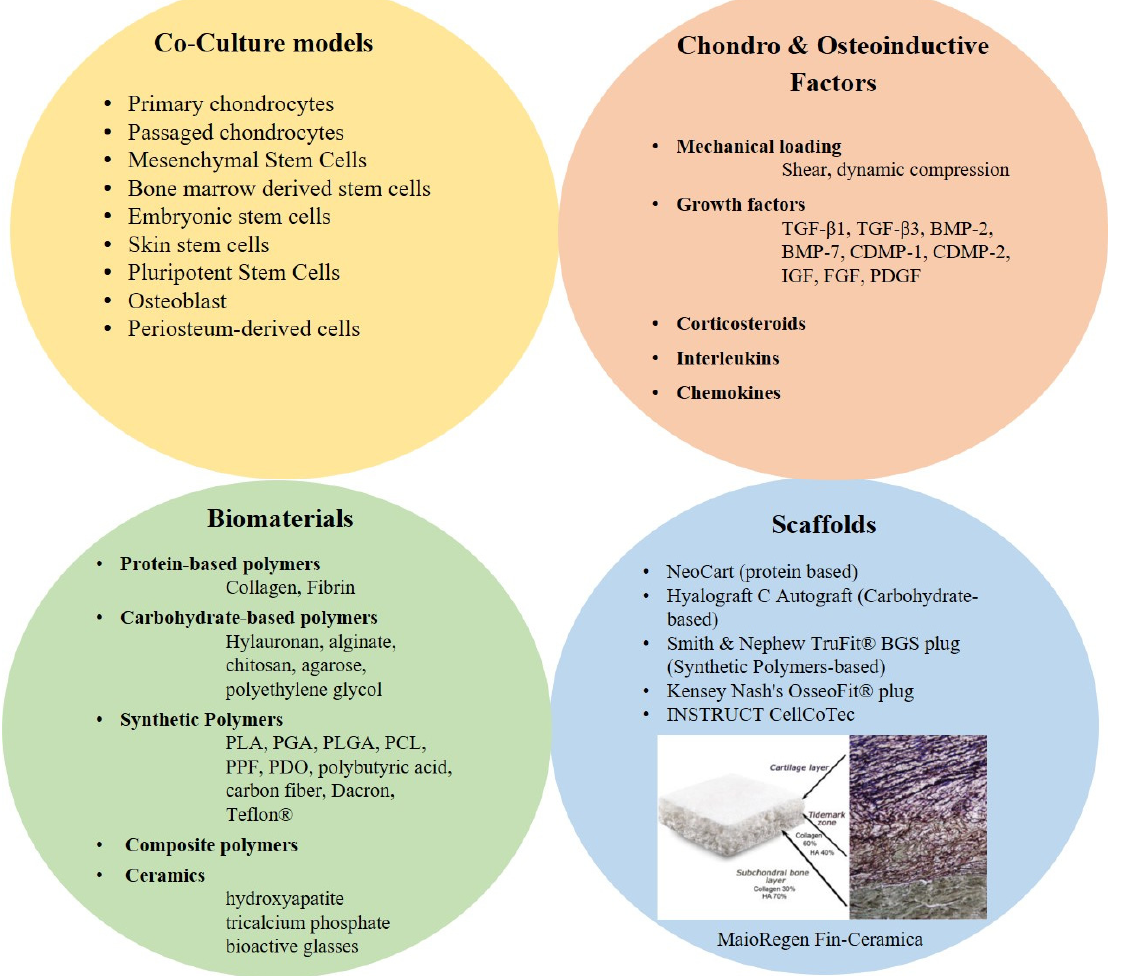
Figure 3. Tissue engineering solutions for osteochondral implants. Co-culture models, biomaterials, scaffolds and chon- dro/osteoinductive factors and signals are the most important parameters of tissue engineering approaches to osteochondral repair. Scaffold image MaioRegen, Fin-Ceramica modified with permission from E. Kon et al., 2010